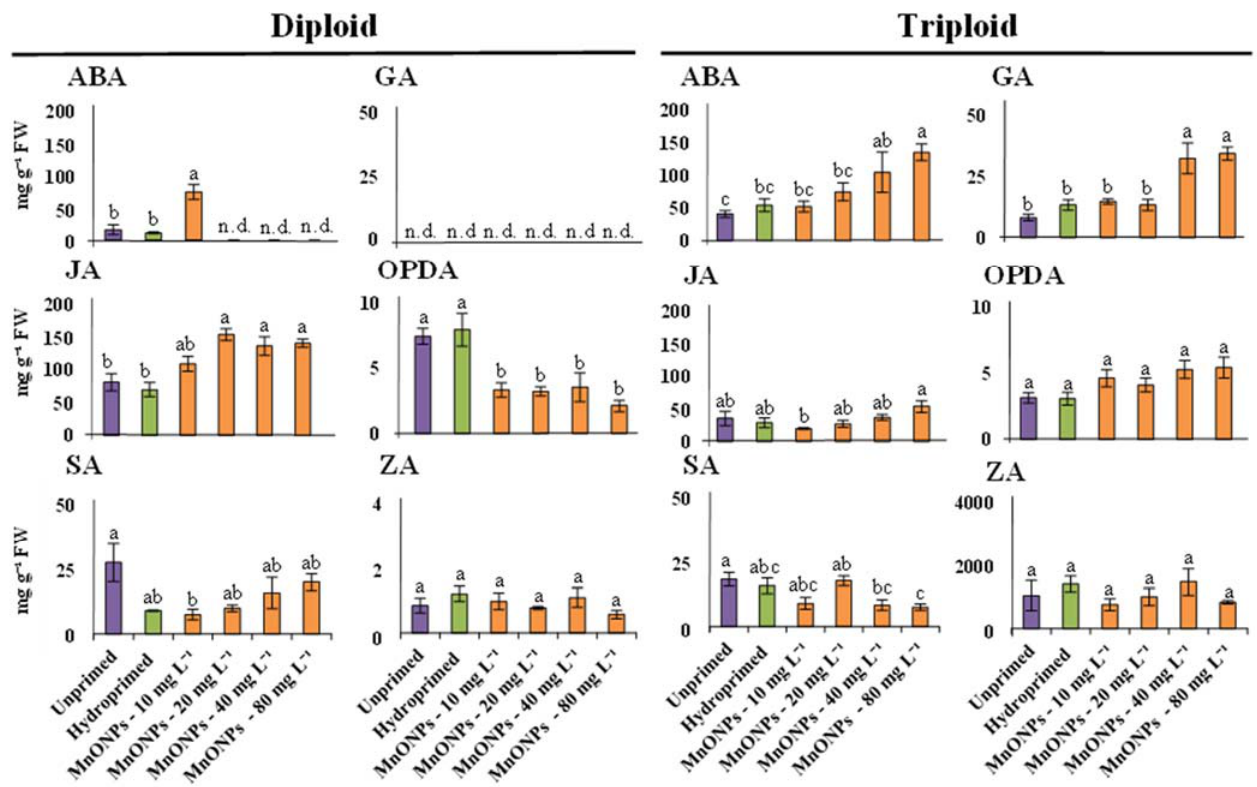
Figure 5. Leaf tissue hormonal profiles in unprimed, hydroprimed, and MnO-NPs-primed diploid and triploid watermelon seedlings. Letters show significant ( p < 0.05) differences based on a post hoc Tukey’s test (ABA, abscisic acid; GA, gibberellic acid; JA, jasmonic acid; OPDA, 12-oxo phytodienoic acid; SA, salicylic acid; ZA, zeatin). Different letters indicate significant differences ( p < 0.05) among treatments according to Tukey’s multiple-range test and n.d. represents not detected.